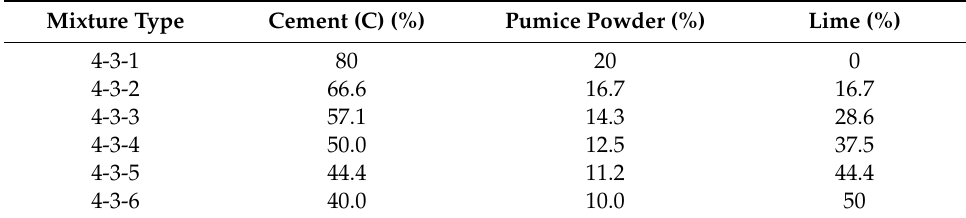
Table 9. Type 4-3 mixing